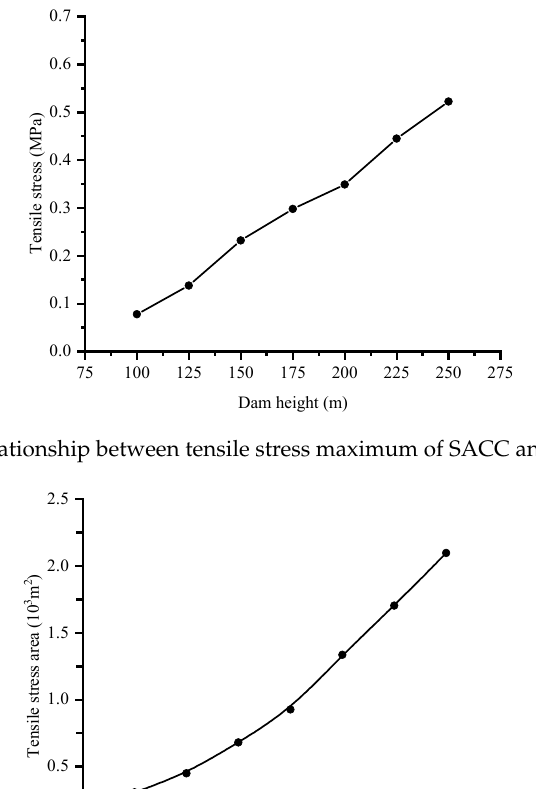
Figure 20. Relationship between flexural deformation maximum of SACC and dam height.